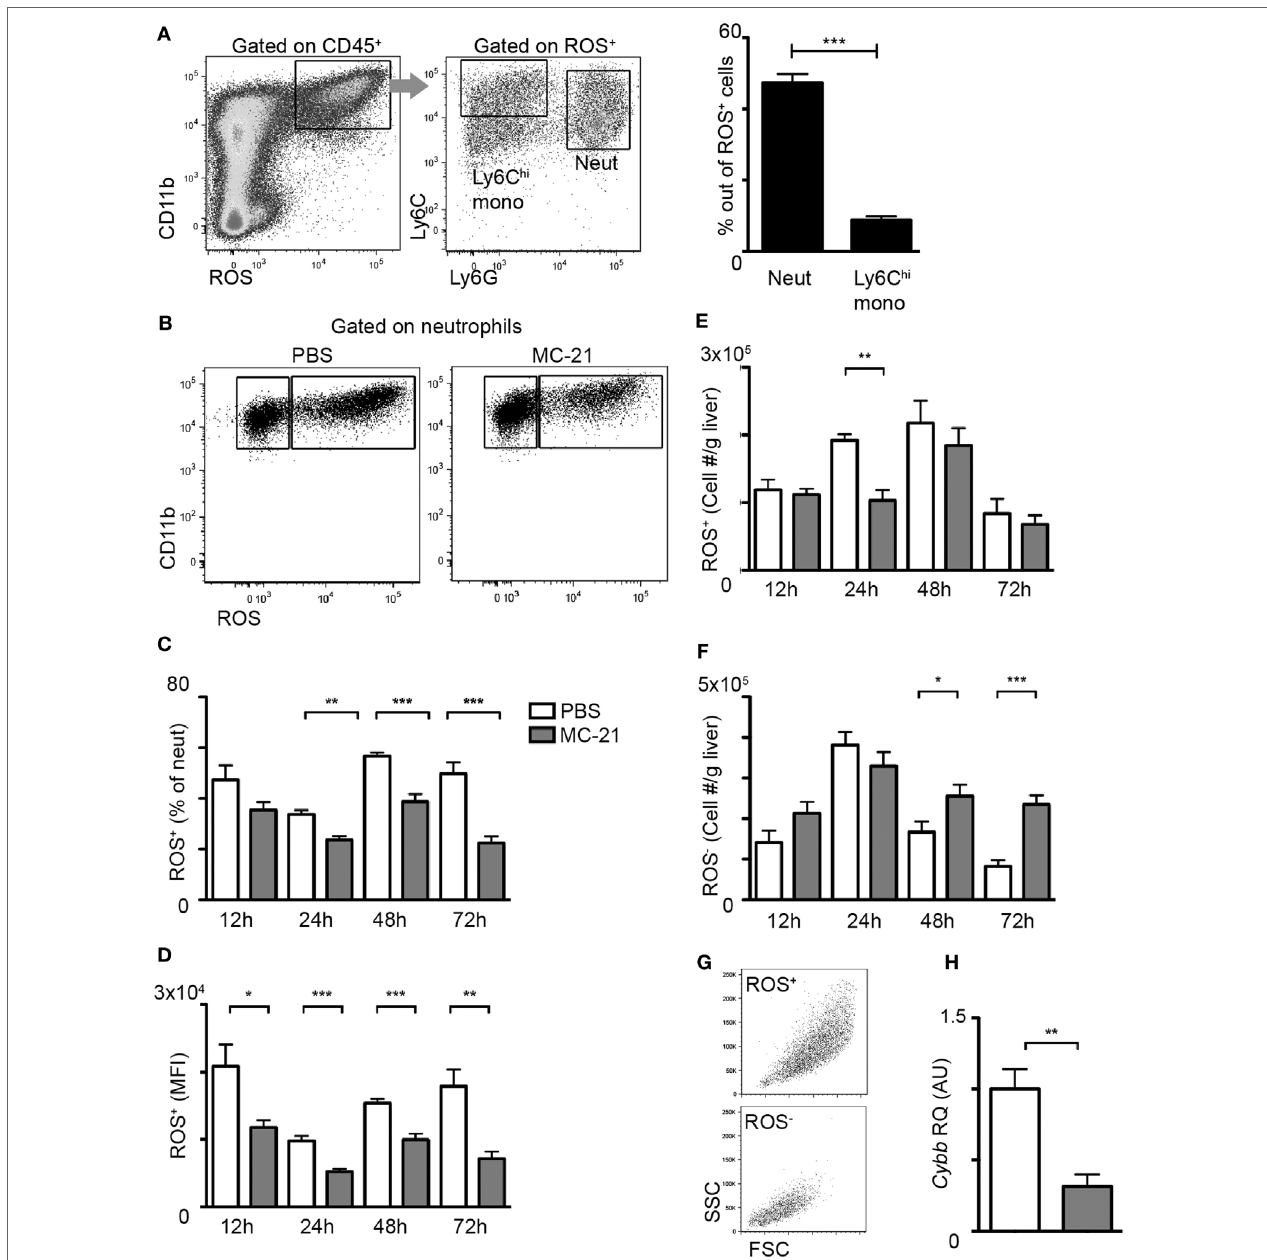
FigUre 3 | reduced neutrophil-derived reactive oxygen species (rOs) production in the absence of ly6c hi monocytes . (a) Flow cytometry and graphical representation demonstrating the definition of CD11b + ROS + cells at acetaminophen-induced liver injury (AILI)-24 h livers and the fraction of Ly6C hi monocytes and Ly6G + neutrophils out of these cells. (B) Flow cytometry analysis at AILI-24 h livers showing ROS staining in neutrophils gated as CD45 + CD11b + Ly6G + Ly6C lo cells. (c–F) Graphical summaries of flow cytometry analyses of injured livers of phosphate-buffered saline (PBS) (white) versus MC-21-treated (gray) mice at 12, 24, 48, and 72 h following AILI showing the (c) fraction of ROS + neutrophils out of total living neutrophils, (D) mean fluorescence intensity (MFI) of ROS out of ROS + neutrophil population, and (e) the numbers of ROS + and (F) of ROS − neutrophils normalized per liver tissue mass in gram. (g) Flow cytometry representation of size (FSC) and granularity (SSC) parameters of ROS + and ROS − neutrophil populations. Note that ROS − cells are smaller and less granular. (h) Graphical representation of quantitative RT-PCR gene expression analysis of Cybb , comparing neutrophils from PBS (white) and MC-21-treated (gray) livers. For A and C-F, data were analyzed by unpaired, two-tailed t -test, comparing each time livers from PBS versus MC-21-treated mice and are presented as mean ± SEM with significance: * p < 0.05, ** p < 0.01, *** p < 0.001 ( n ≥ 5 mice/group for each time point). For H, data were analyzed by unpaired, two-tailed t-test, comparing sorted neutrophils from livers of PBS (white) versus MC-21-treated (gray) mice and are presented as mean ± SEM with significance: ** p < 0.01 ( n ≥ 4